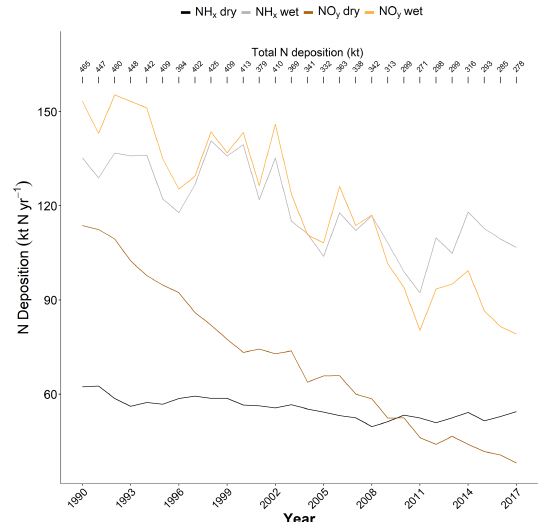
Figure 8. Four forms of total nitrogen (N) deposition over the UK terrestrial surface from 1990 to 2017, for grid average land cover: total wet and dry deposition of reduced N (NH x ) and wet and dry deposition of oxidised N (NO y ) (ktNyr − 1 ).